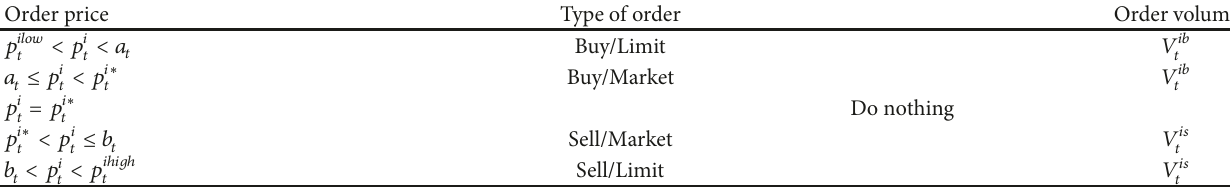
Table 1: Summary of the trading mechanism of agent “i” at time “t”.